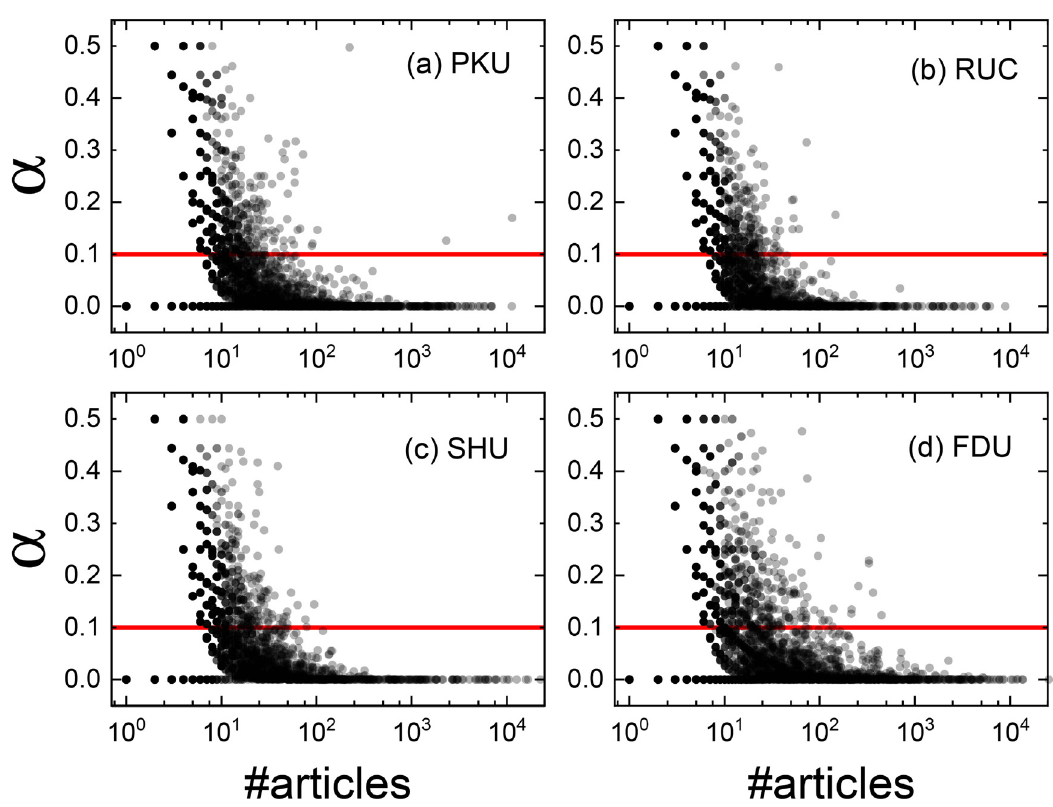
Fig 2. Relation between p -value and user activity. The red lines correspond to the significance level α = 0.1. More than 70% points are below the line in each university.